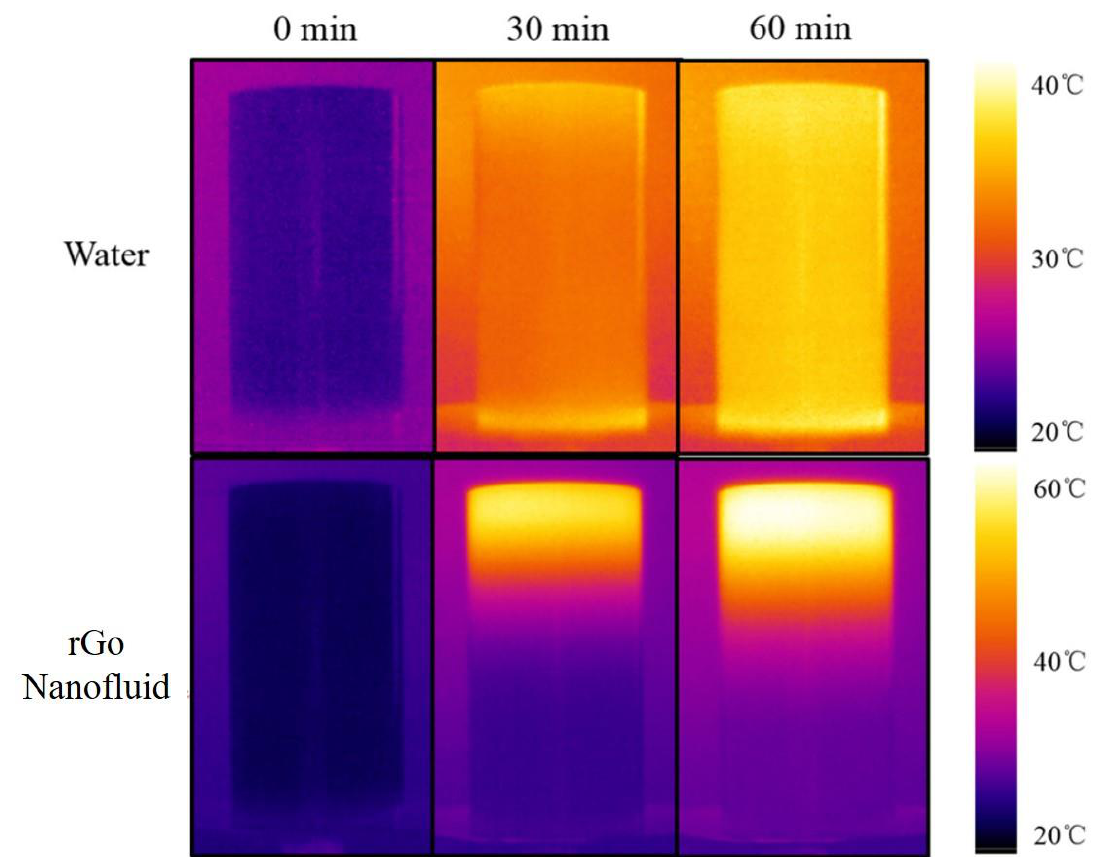
Figure 30. IR thermal images of water and rGO nanofluid at different times [99]; 2018, Elsevier.